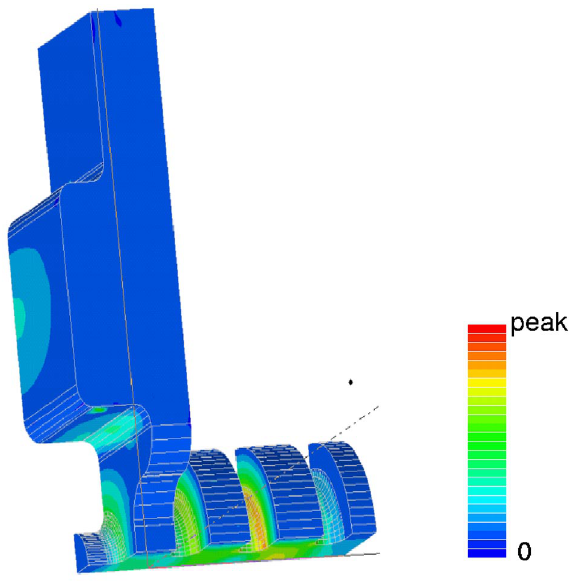
FIG. 5. (Color) Quarter geometry of a waveguide coupler with electric field plot.